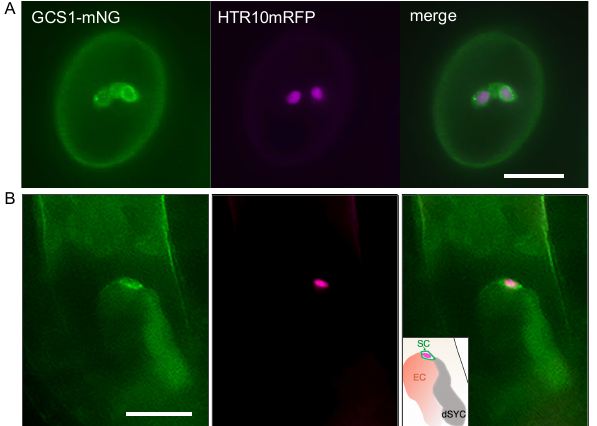
Figure 2. GCS1/HAP2 distribution in the sperm cell before fertilization. ( A ) Fluorescence images of mature pollen from GCS1-mNG dmp8dmp9 •HTR10mRFP plant. GCS1/HAP2 and the sperm cell nuclei are visualized with mNG (left panel) and HTR10mRFP (middle panel), respectively. The right panel is the merged image. Each sperm cell is at a different focus, indicating that GCS1/HAP2 preferentially distributes at the perinuclear (right sperm). The dot-like signals reflect the distribution of the endomembrane system in the cytoplasm (left sperm). The photo of the sperm cells at the same focus plane is indicated in Figure S7A. Bar = 10 µm. ( B ) GCS1-mNG in the arrested dmp8dmp9 sperm cells in an embryo sac. The left, middle, and right panels are the GCS1-mNG, mRFP, and the merged images, respectively. The inset in the right panel represents the schematic explanation of the observed image. SC: arrested sperm cell; EC: egg cell position; dSYC: degenerated synergid cell. Bar = 20 µm.